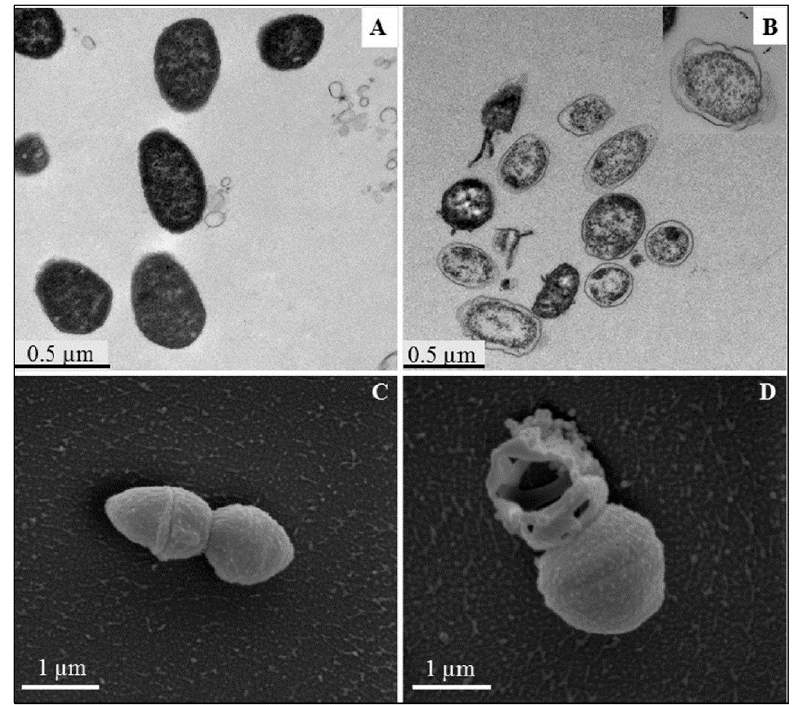
Figure 6. TEM ( A , B ) and SEM ( C , D ) images of L. monocytogenes cells: ( A , C ) untreated cells (control groups) and ( B , D ) cells treated with different concentrations of AgNPs, adapted with permissions from [94], Elsevier, 2018.